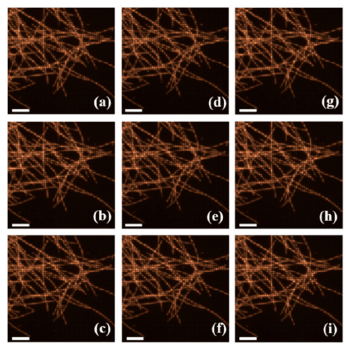
Figure 6. Nine raw multifocal images ( a – i ) of the fixed sample of Melosira. Scale bars: 40 μ m.